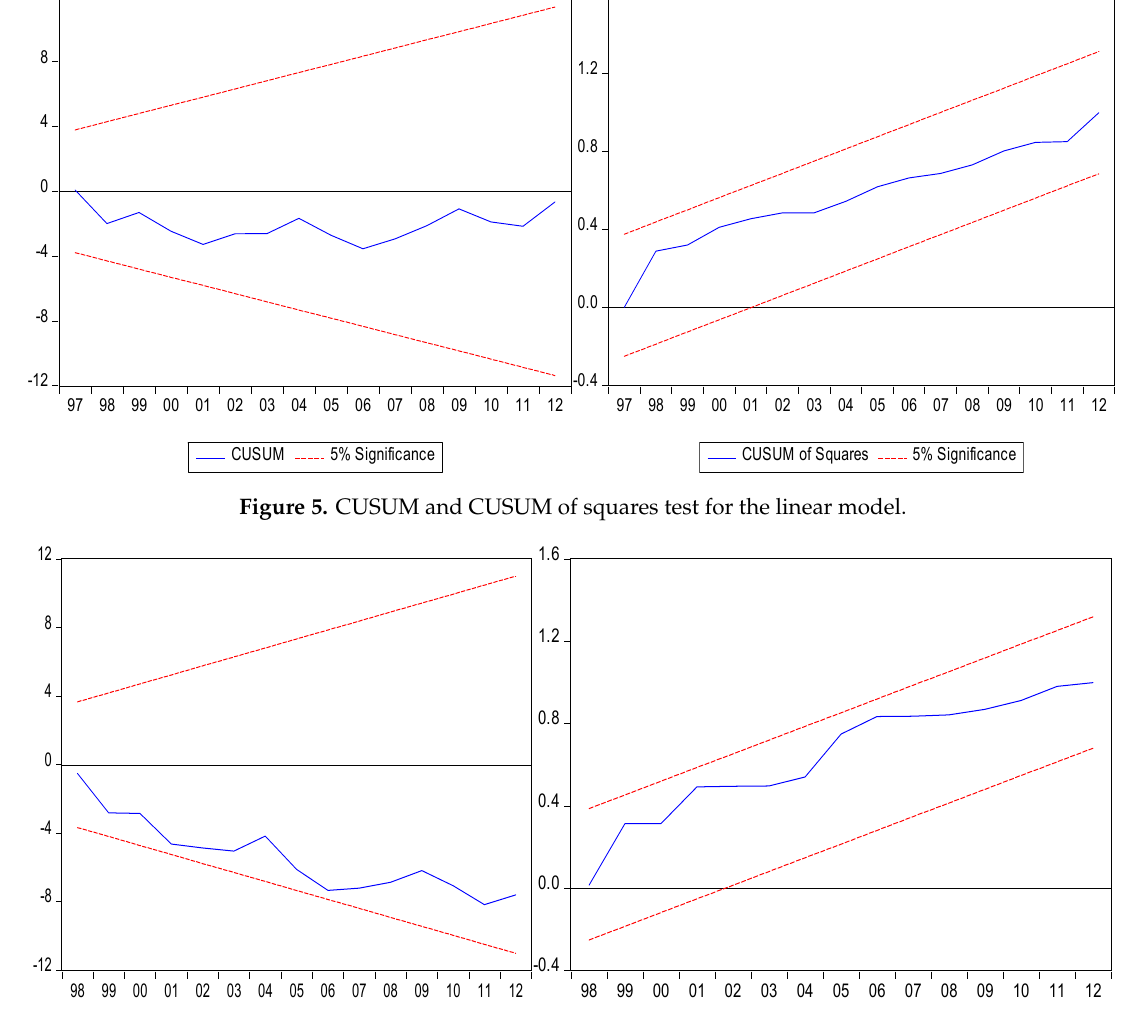
Figure 6. CUSUM and CUSUM of squares test for the squared model.